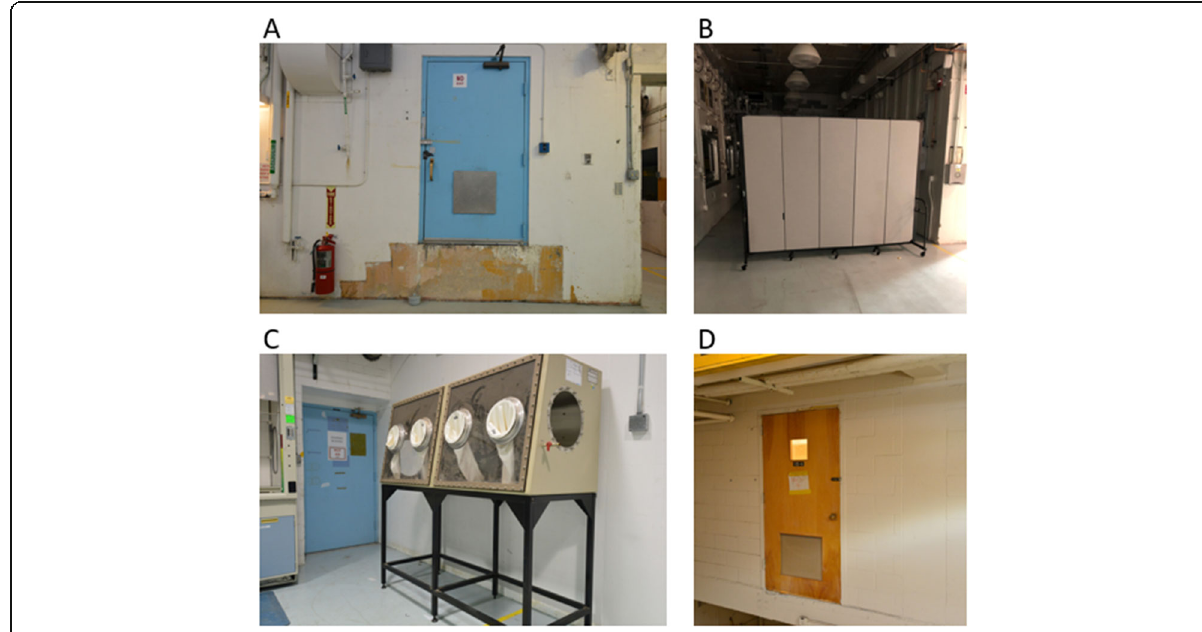
Fig. 3 Photographs of some of the inconsistencies between the simple map and the building. Image a shows the stairs that have been removed and one of the non-functional doors. Image b shows the rolling partition, which is not depicted on the map. Image c shows another of the non- functional doors. Image d shows the third non-functional door and the area where the catwalk on the mezzanine has been removed. The sign on the door says, “ Watch your step